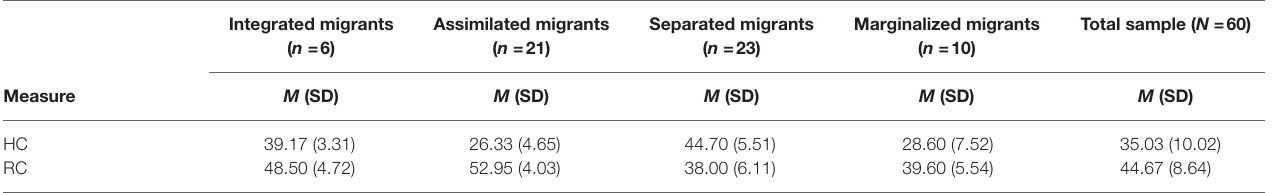
TABLE 4 | Means and standard deviations of orientation toward the heritage culture (HC) and orientation toward the receiving culture (RC) of the Iranian migrant sample.